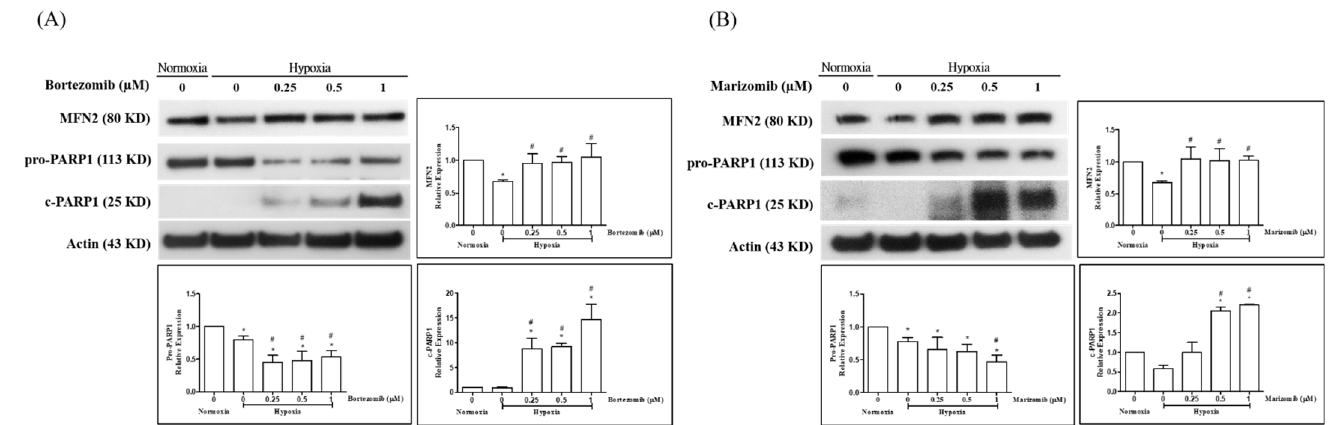
Figure 2. Proteasome inhibitors restored the expression of MFN2 and induced apoptosis under hypoxic conditions. HPASMCs were exposed to hypoxic conditions and were treated with bortezomib and marizomib for 24 h. The expression of MFN2, pro-PARP1, and cleaved PARP1 were detected by Western blotting. The expression of actin was used as a loading control. Bortezomib ( A ) and marizomib ( B ) restored the expression of MFN2-inhibited by hypoxia, inhibited the levels of pro- PARP1, and induced the level of cleaved PARP1. One-way ANOVA was used to determine the differences between the experimental and vehicle control (DMSO) groups and the Newman–Keuls Multiple Comparison Test was used as a post hoc test following ANOVA. The data represent means ± standard error of three independent experiments. * p < 0.05 versus normoxic group. # p < 0.05 versus hypoxic control group.